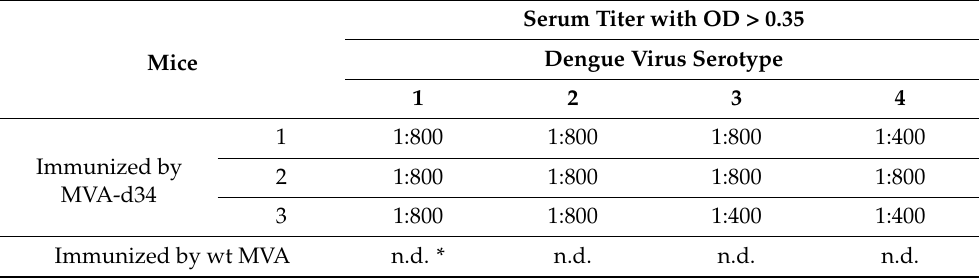
Table 2. The results of the analysis of blood sera of mice immunized with MVA-d34 and mice immunized with wt MVA for the presence of antibodies against different dengue virus serotypes using the in-house indirect sandwich ELISA test.